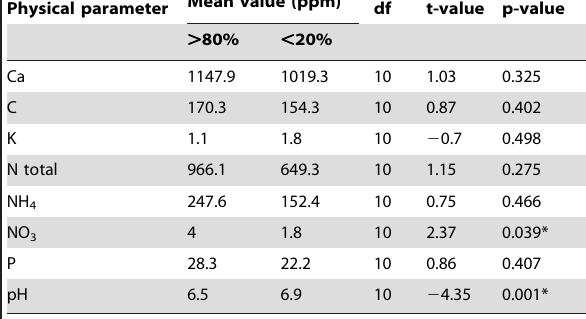
*Denotes significance of differences between mean values.